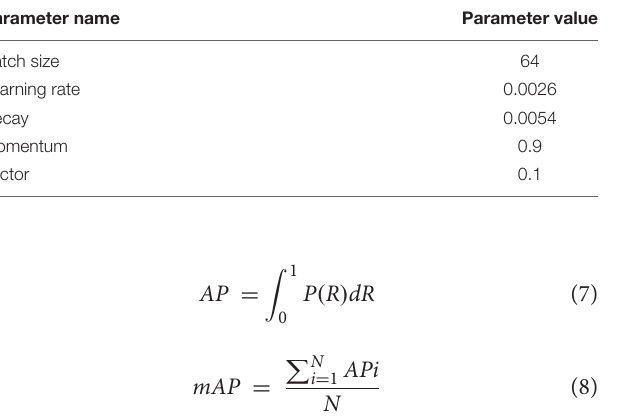
FIGURE 8 | Precision–Recall curves of the proposed model at four different image resolutions.